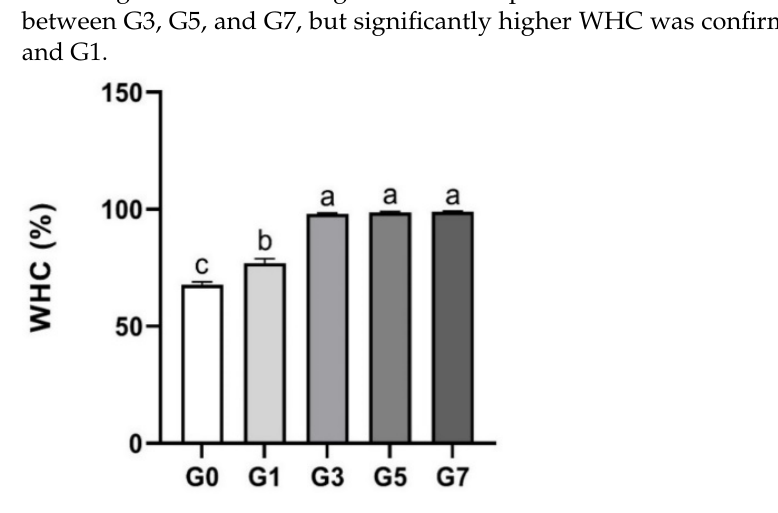
5 of 10 Figure 1. The hardness of abalone 3D print ink according to gelatin concentration (0–7%). Error bars represent the standard deviation, and different letters on the top of the column indicated a signifi- cant difference ( p < 0.05). The APIs according to gelatin concentration showed a significant increase in hard- ness, and the elderly food standards also showed differences. The results of G0 (6.6 ± 2.1 kN/m 2 ) and G1 (15.4 ± 1.3 kN/m 2 ) were under 20 kN/m 2 and came out as the third level of elderly food standard; G3 (54.5 ± 4.3 kN/m 2 ), G5 (85.2 ± 2.9 kN/m 2 ), and G7 (107.4 ± 4.1 kN/m 2 ) were in the more hardness stage (first level, which is over 50 kN/m 2 ). All APIs containing 1 to 7% gelatin met the criteria for the properties of elderly foods.